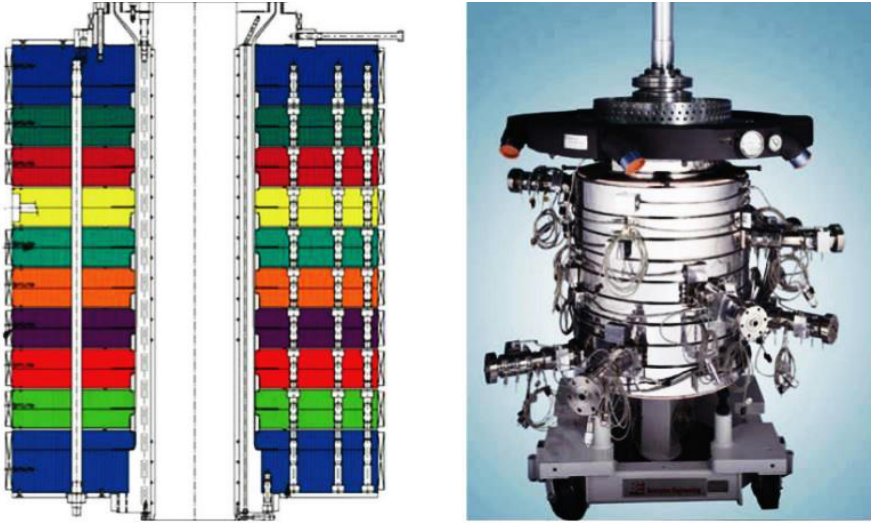
Figure 13. Schematic and commercial example of a multilayer stacked plate or “pancake” die. Adapted from [85].